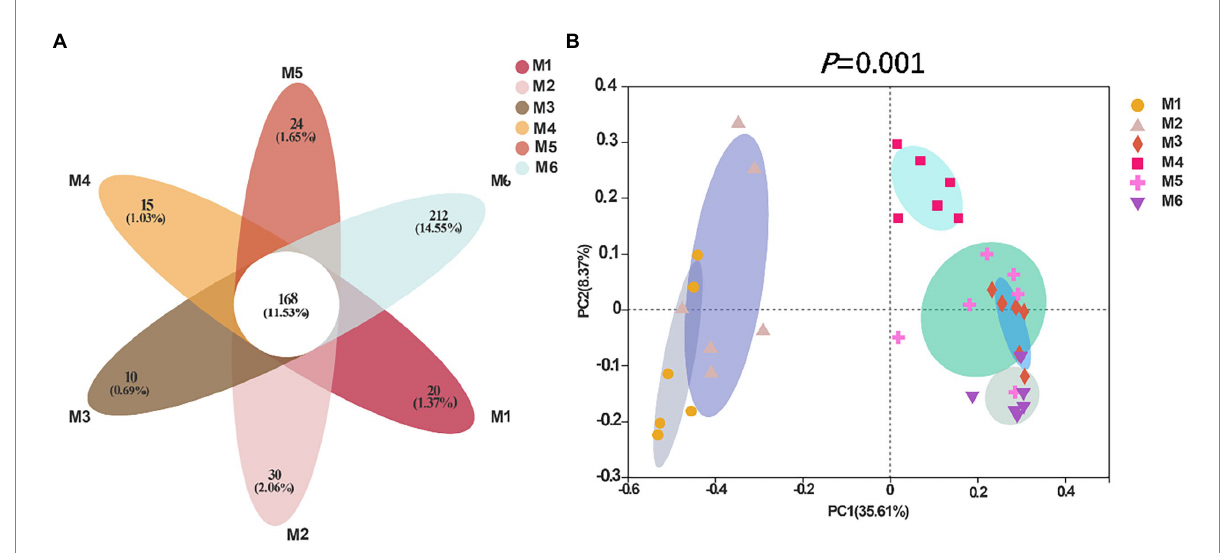
FIGURE 5 Flower diagram plot and beta-diversity analysis of the fecal microbiota of calves in different age groups. (A) Flower diagram plot. OTUs present in all groups are identified as the core community of all groups. (B) Principal coordinates analysis (PCoA) plots of microbiota in different samples; the number of calves in each of the six groups was